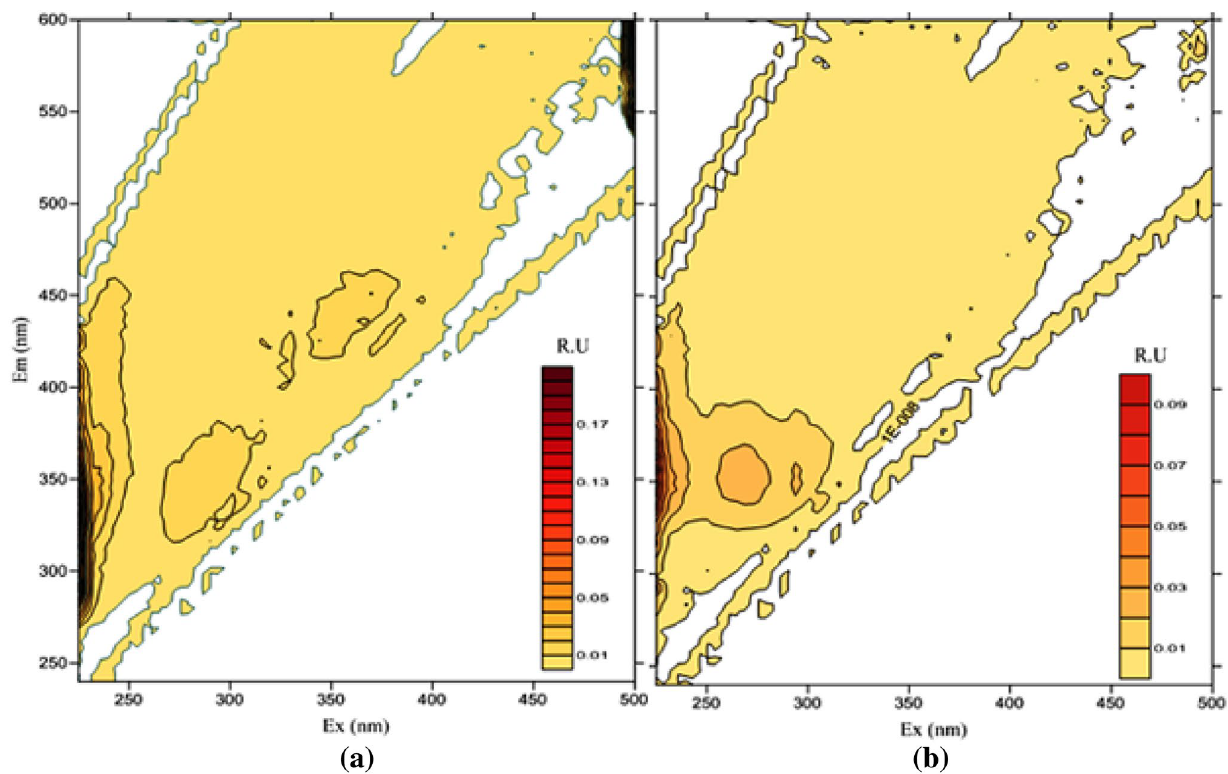
Fig. 7 A representative illustration of the three-dimensional excitation emission matrix (3DEEM) fluorescence spectra of PB dye solution. a Raw solution, b at 20 h of irradiation in the presence of Fe 2 O 3